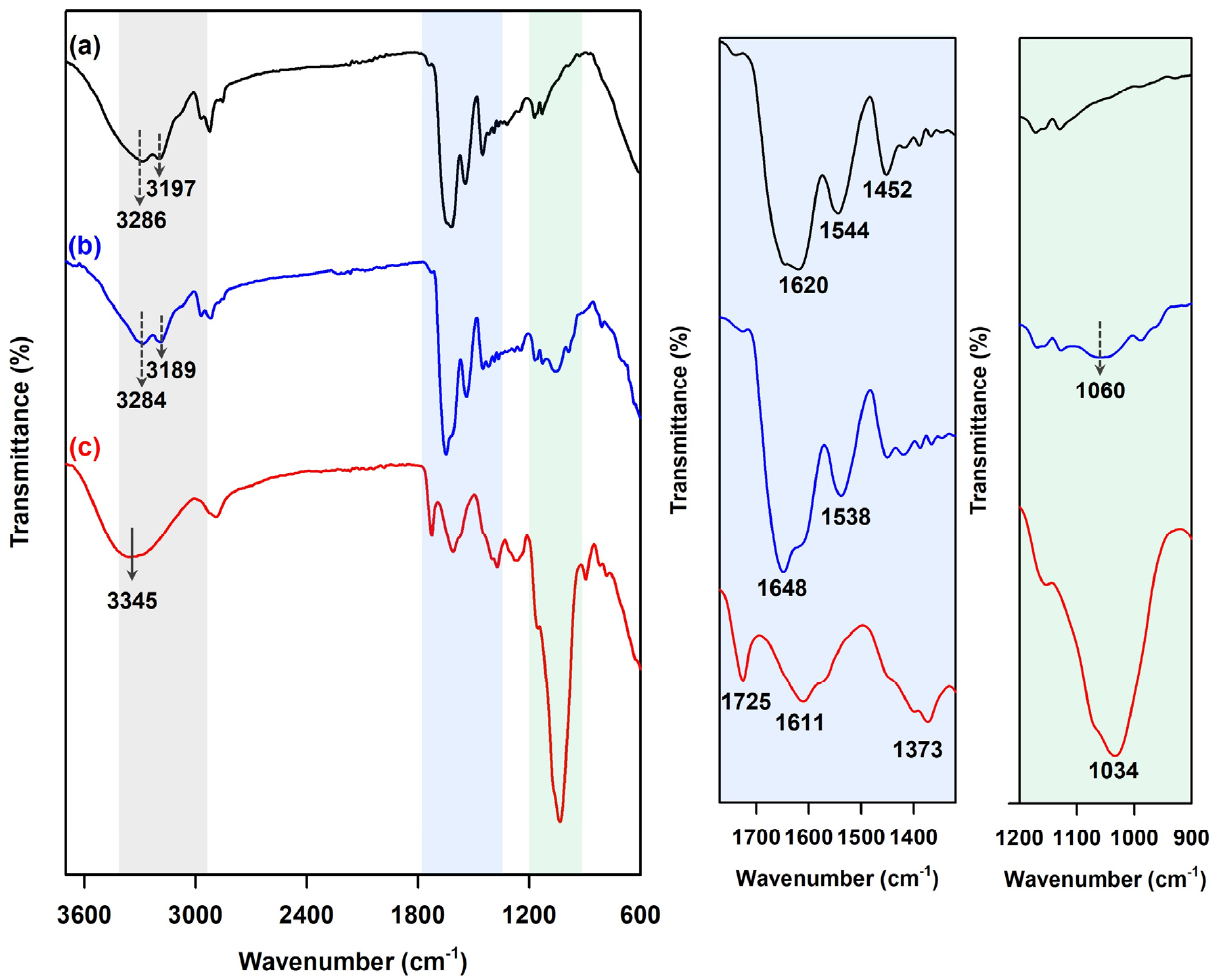
Figure 1. ATR-FTIR spectra of ( a ) P(NIPAM), ( b ) OSG/P(NIPAM-AM), and ( c ) OSG. XRD pattern of OSG showed broad diffraction peaks at 2 θ = 19 ◦ , as well as shifting and implied that the structure of SG was changed during oxidation, and the intermolecular pattern of the P(NIPAM-AM) hydrogels has a broad peak at 2 θ = 21.8 ◦ associated with the AM) at 2 θ = 27.4 ◦ , 31.9 ◦ , 45.7 ◦ , and 56.5 ◦ , indicating crystalline properties [40]. The